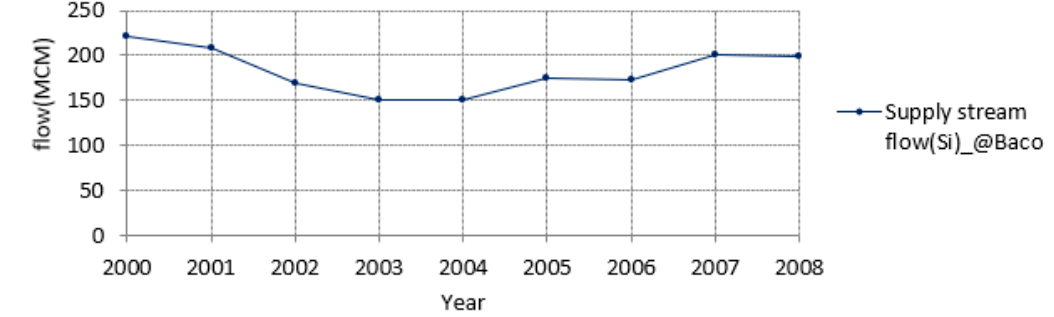
Figure 13. Annual supply flow to Gibe river near Baco gauging station.